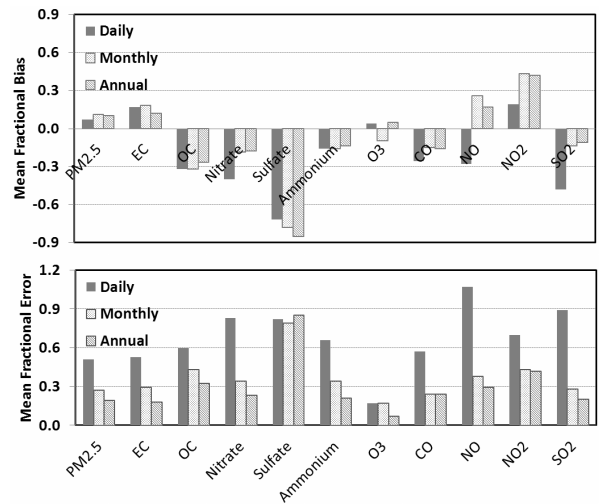
Figure 4. Mean fractional bias and mean fractional errors of PM and gaseous species when calculated using daily, monthly, and annual